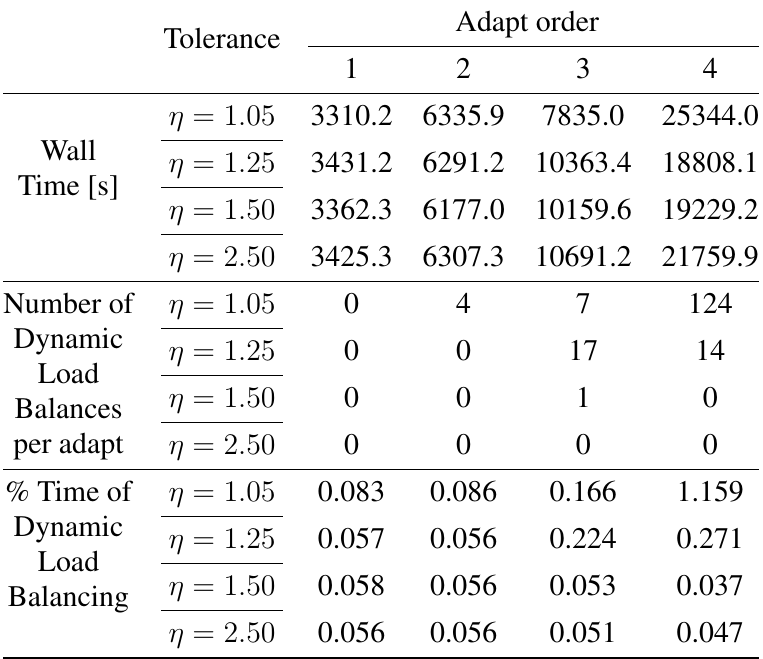
Table 2: Sensitivity analysis for imbalance tolerance. Comparisson of the effect of various values of imbalance tolerances on the runtime, DLB time and DLB occurrences as a function of adapt